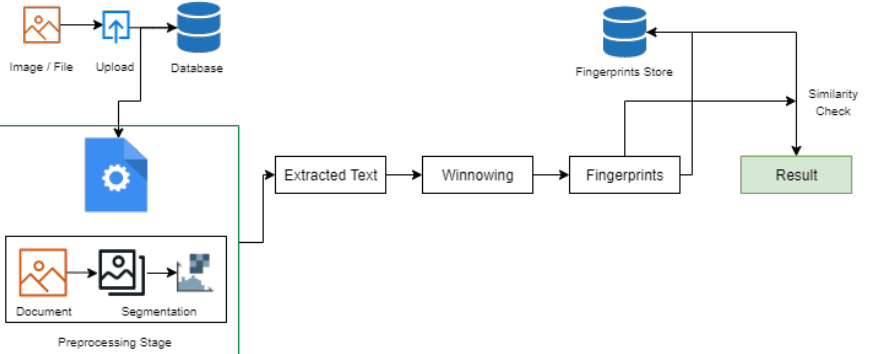
Figure 5. Steps performed in this experiment.